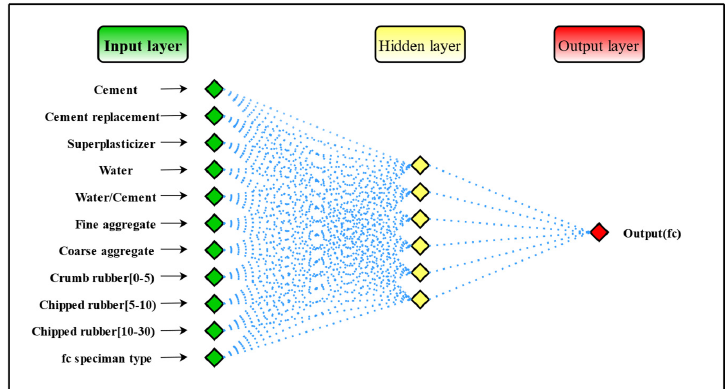
Figure 6. ANN structure used in this study.